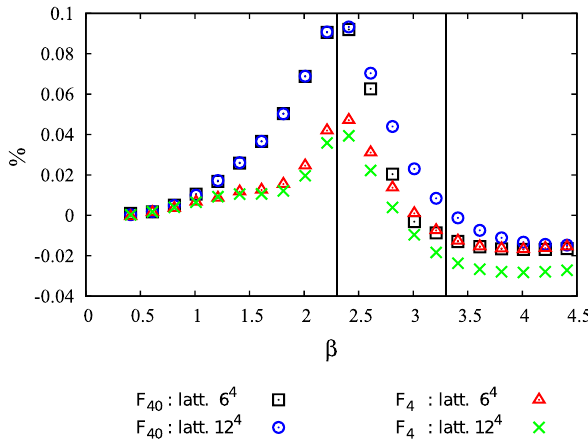
Fig. 7 The same as in Fig. 6 but for the relative deviation of the results obtainedwithpresentalgorithmwithrespecttotheheatbathresults.The vertical black lines show the interval of β values where the efficiency of the nonlocal update is higher. See text for